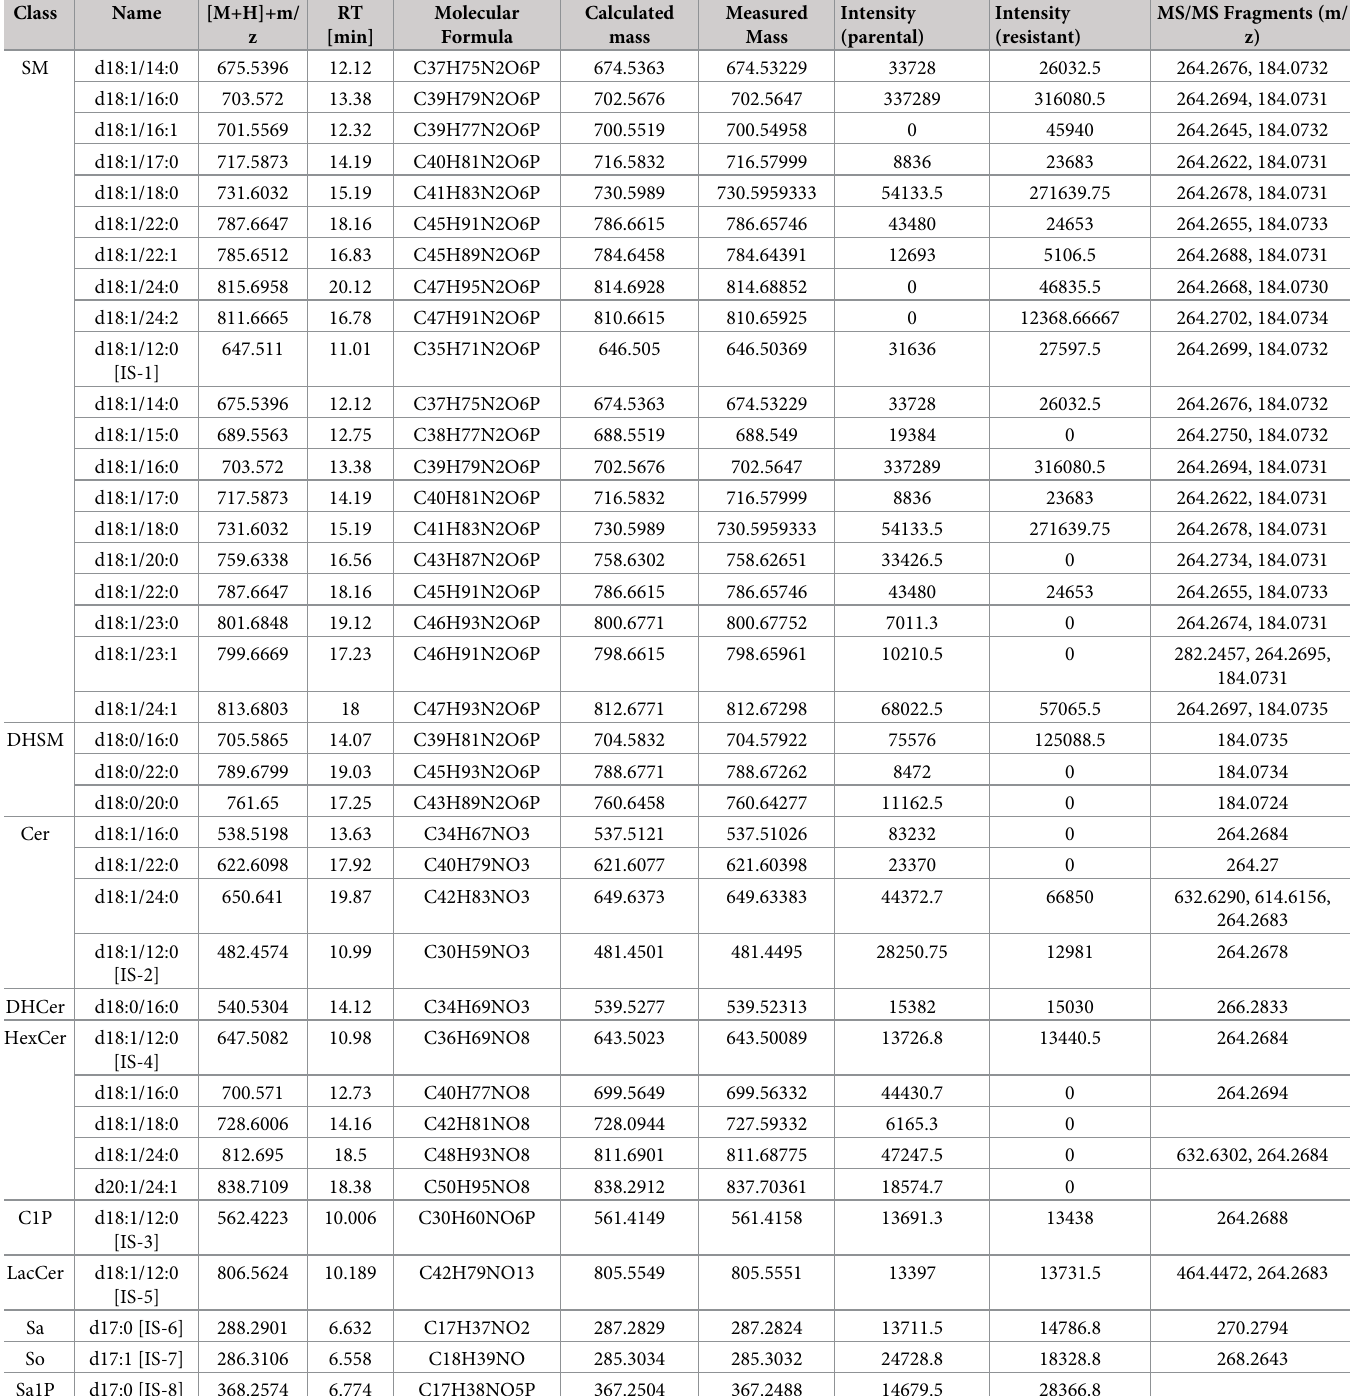
Table 2. Identification of SPLs in parental and dox-resistant MCF-7 cells using